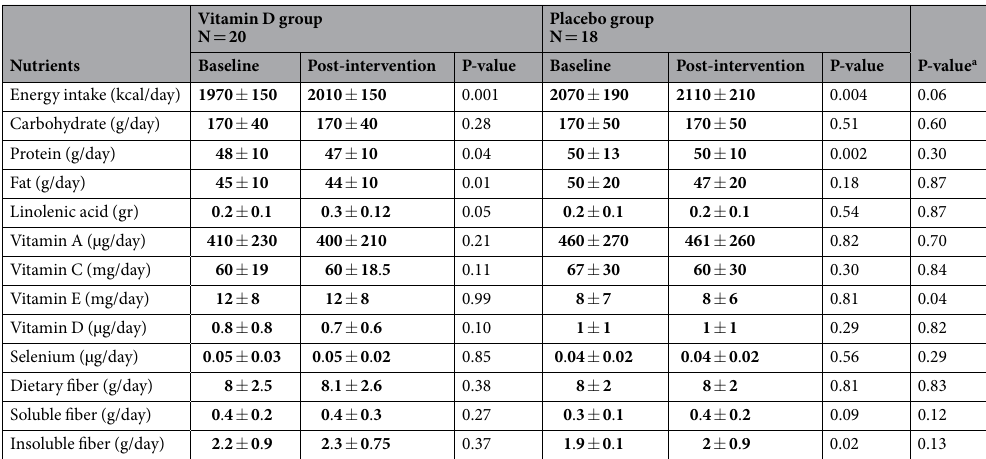
Table 2. Dietary intakes of the two study groups. Data are shown as mean ± SD. a Resulted from independent